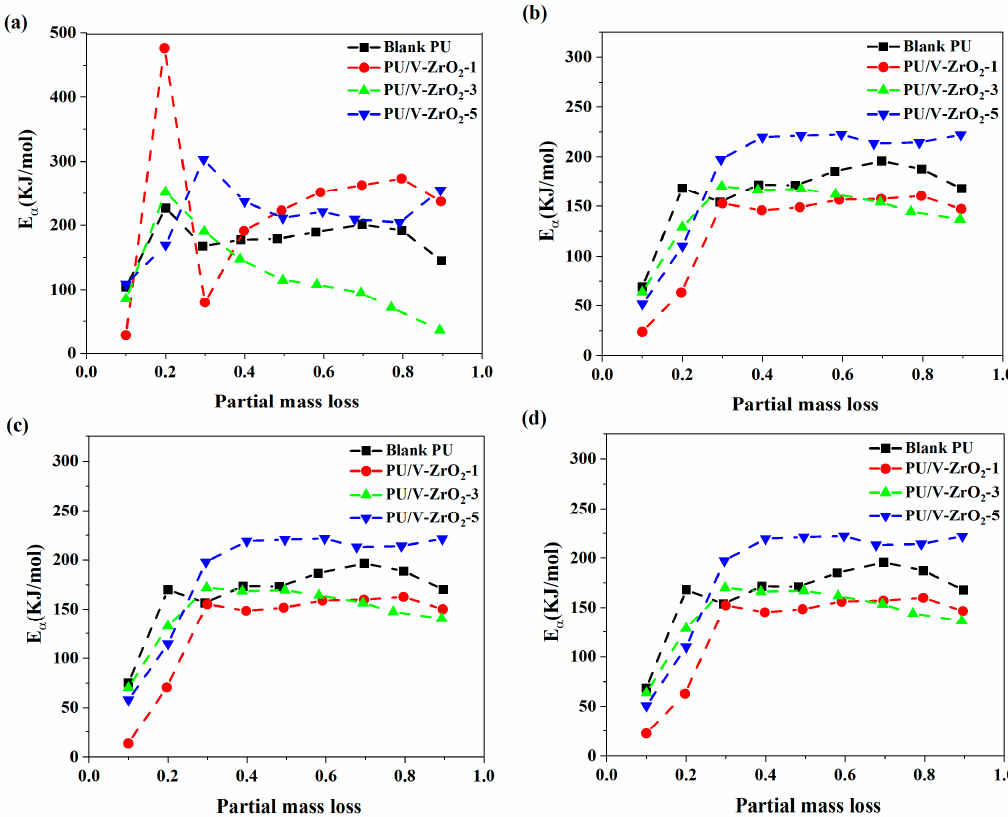
Figure 6. Activation energy of blank PU and its nanocomposites containing 1, 3 and 5 wt.% of V-ZrO 2 nanoparticles in terms of partial mass loss obtained using ( a ) Friedman ( b ) KAS , ( c ) FWO and ( d ) m-CR methods.